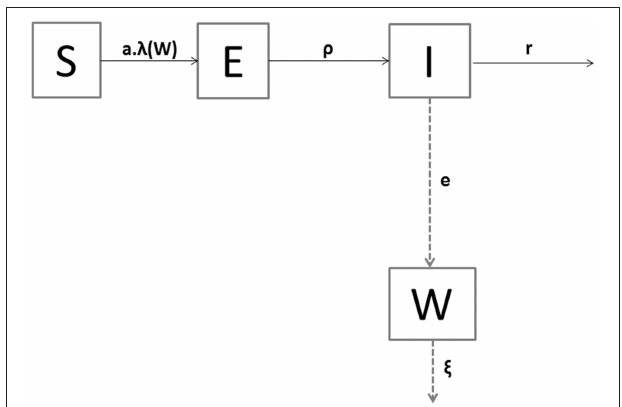
FIGURE 2 | Compartmental model of Vibrio aestuarianus spread among oysters and in their environment. The health states of oysters are S for susceptible, E for exposed, and I for infectious. W denotes the seawater concentration of free-living bacteria. Solid arrows indicate oyster transitions between heath states. Dashed arrows represent the dynamics of the pathogen population. The description of parameters is the same is in Table 1 .